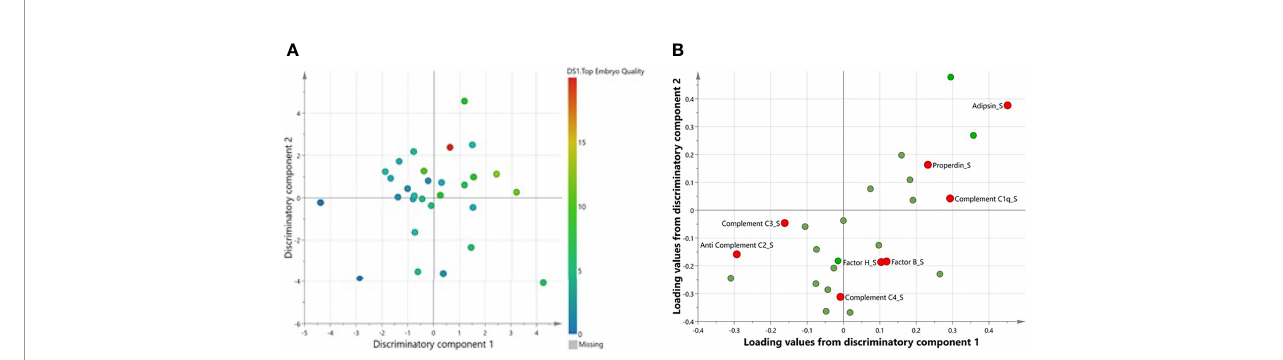
FIGURE 5 | A multivariate OPLS con fi rming complement factors associated with number of top-quality embryos. (A) Scores plot from OPLS-DA showing two discriminatory components for top embryo quality. (B) Corresponding loadings plot from OPLS-DA. Signi fi cantly different complements are highlighted in